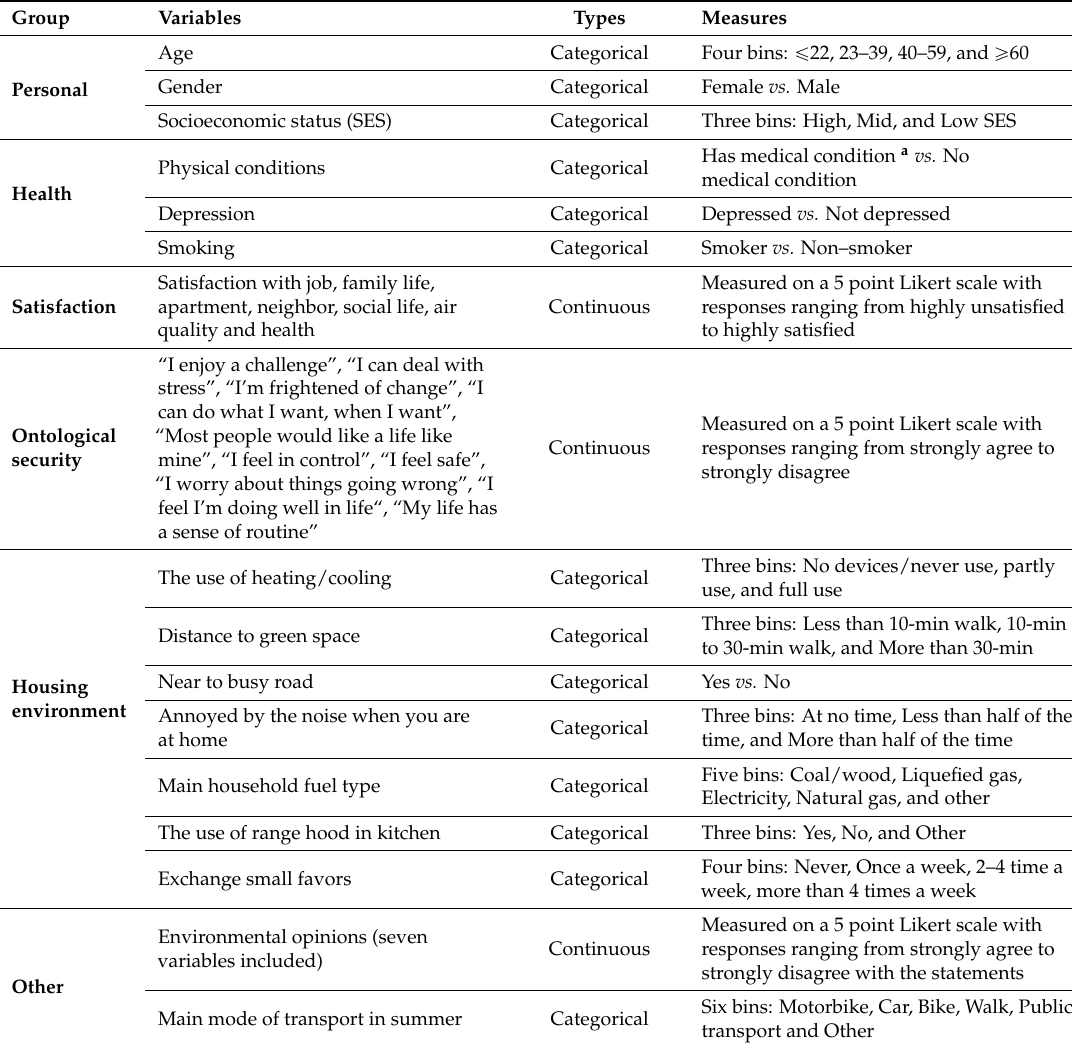
Table 2. Descriptions of the independent variables.